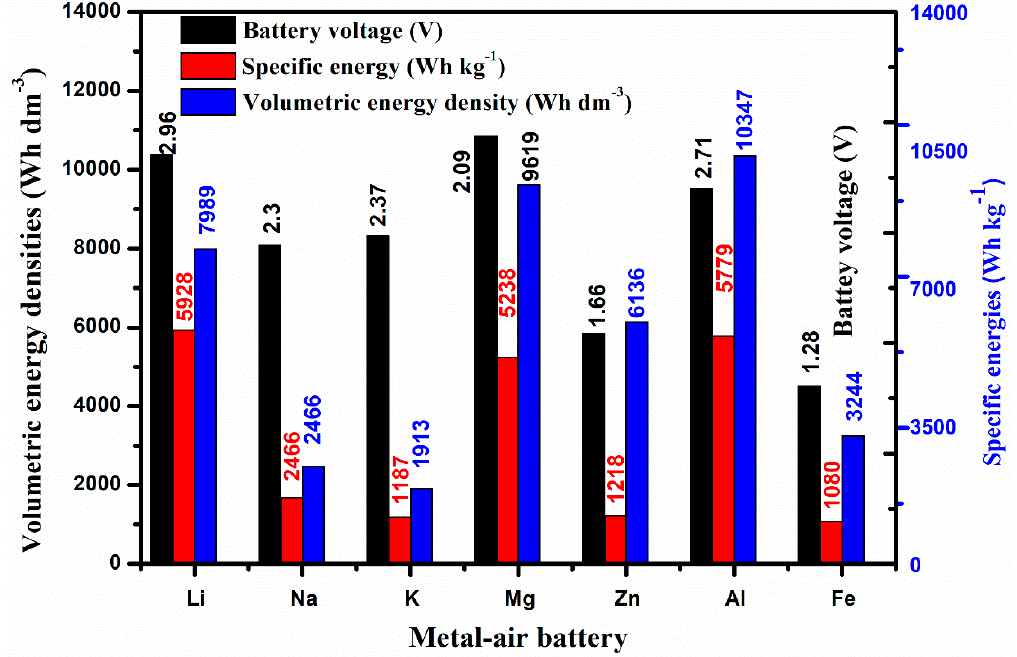
Figure 2. Theoretical specific energies, volumetric energy densities, and nominal battery voltages of various metal–air batteries (MABs) [9].